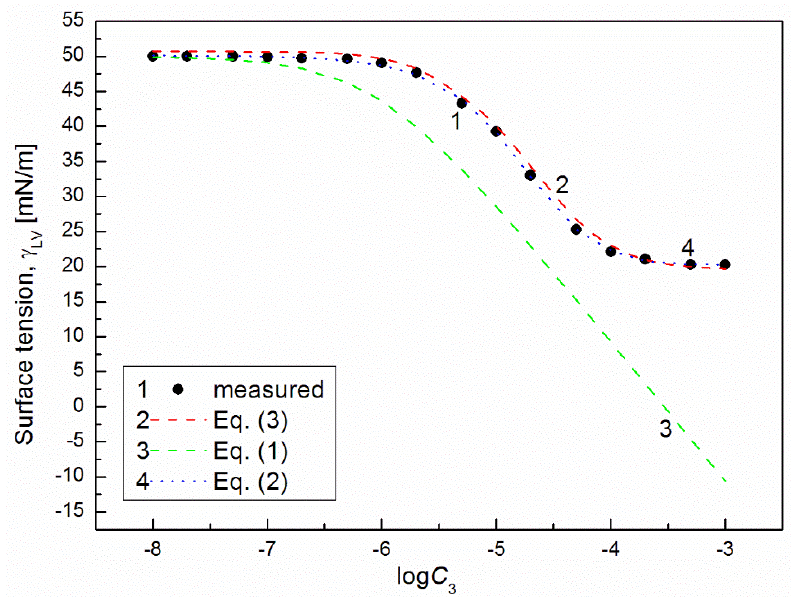
Figure 4. A plot of the surface tension ( γ LV ) of the aqueous solutions of CTAB + TX100 + FC2 mixture at the constant concentration of the binary mixture CTAB + TX100 ( C 12 ) and γ LV = 50 mN/m (m2 (50)) vs. the logarithm of FC2 concentration ( logC 3 ). Points 1 correspond to the measured values, curves 2, 3 and 4 correspond the values calculated from the Fainerman and Miller (Equation (3)), the Szyszkowski equation (Equation (1)) and the second order exponential function (Equation (2)), respectively.